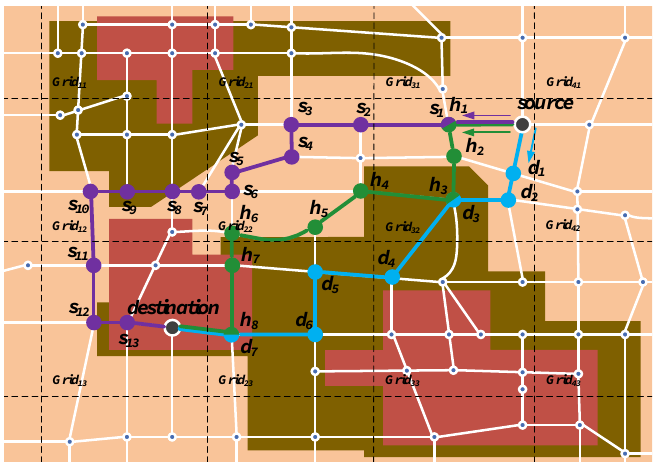
Figure 10. Comparison results of situational grid heuristic search, heuristic search and breadth traversal